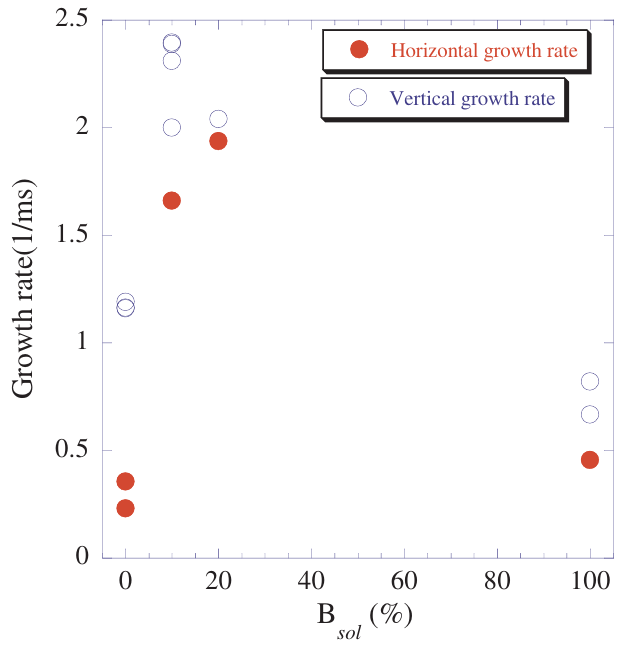
FIG. 11. (Color) Horizontal (solid circle) and vertical (open settings. circle) growth rates of the instability with different B sol correspond to the experimental Note that points in the same B sol result with different linear chromaticity. These growth rates are (cid:1) 1 : 5 and (cid:6) (cid:1) 0 : 8 so that they have converted to those for (cid:6) x y offset (cid:3) 0 : 16 ms (cid:3) 1 , both for horizontal and vertical planes. The chromaticities ranged over 1 : 08 (cid:5) 9 : 36 and 0 : 8 (cid:5) 9 : 64 for the horizontal and vertical planes, respectively.